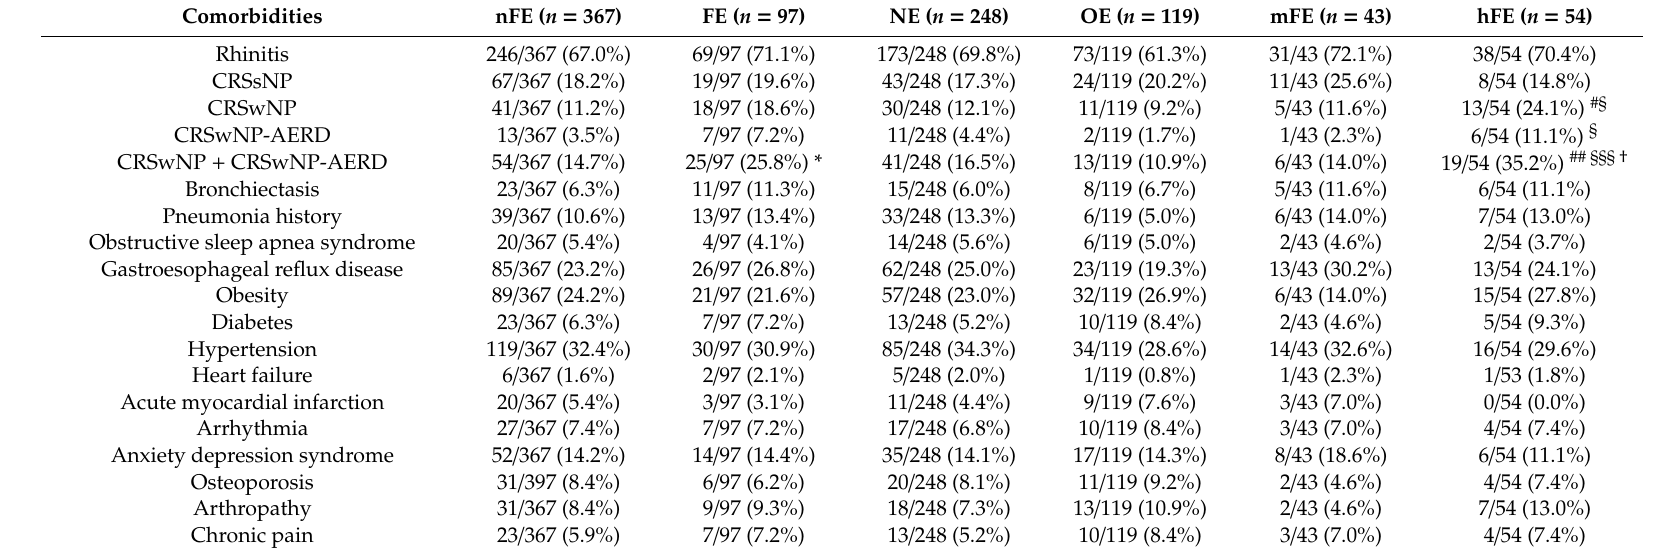
Table 2. Prevalence of comorbidities in the asthmatic